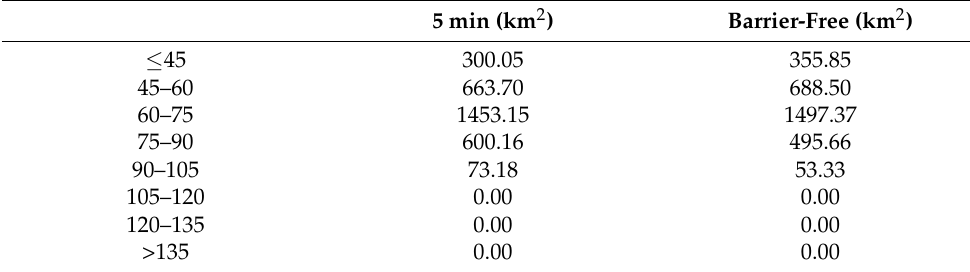
Figure 4. Spatial distribution pattern of accessibility. Note: The map is based on the standard map of the Map Technical Review Centre of the Ministry of Natural Resources of China (Number: GS (2019)4342), with no modifications to the base map; Map-making by author. Table 5. Comparison of accessible areas.